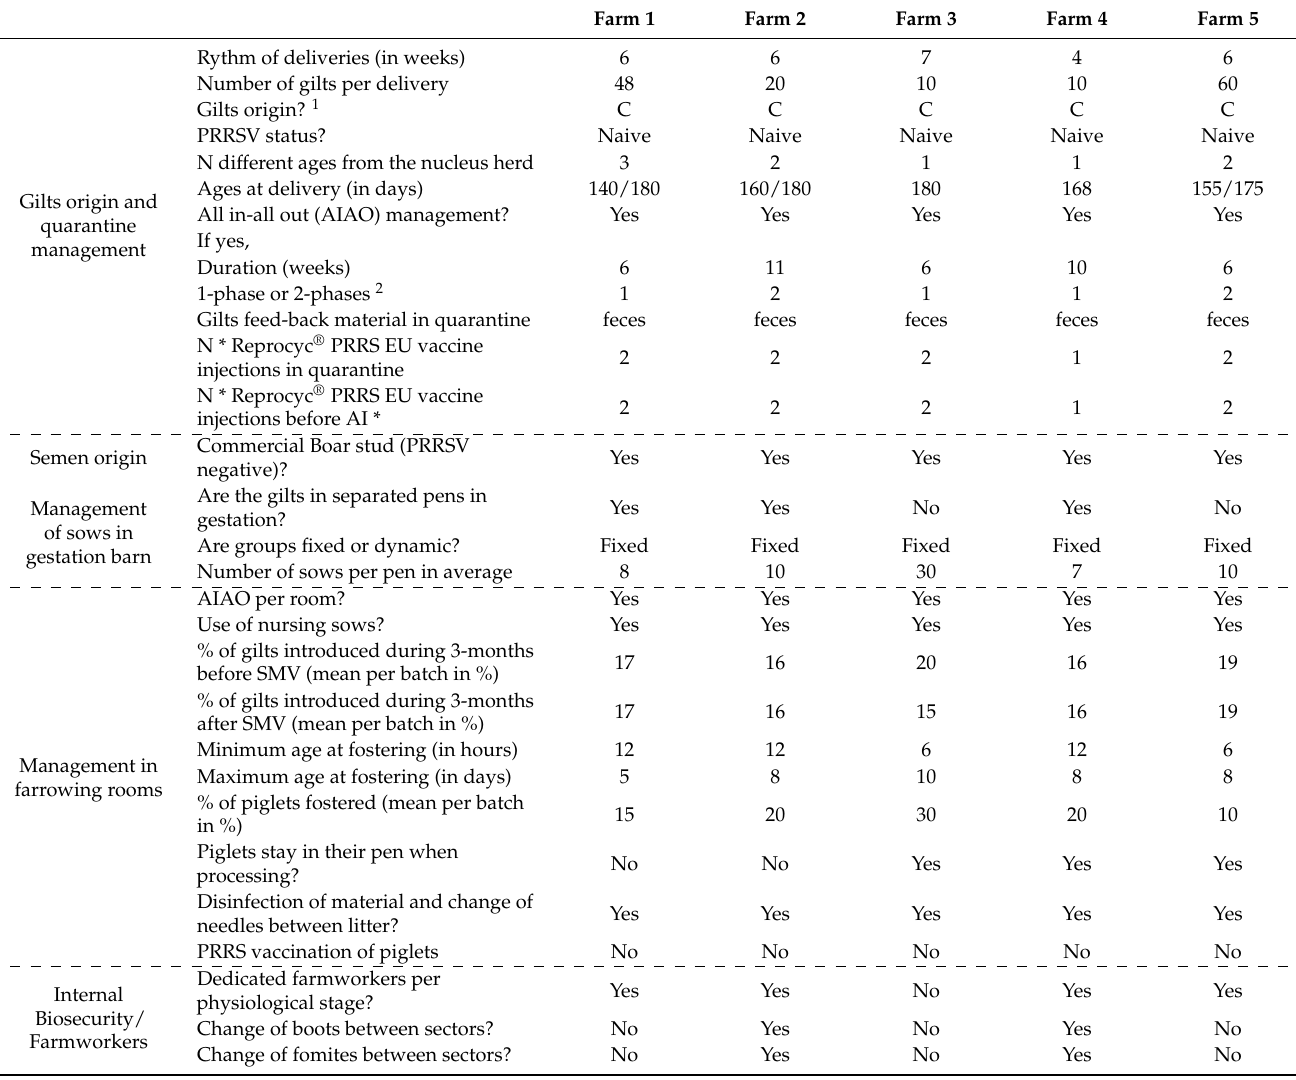
Table 3. Farm information records based on audit questionnaire